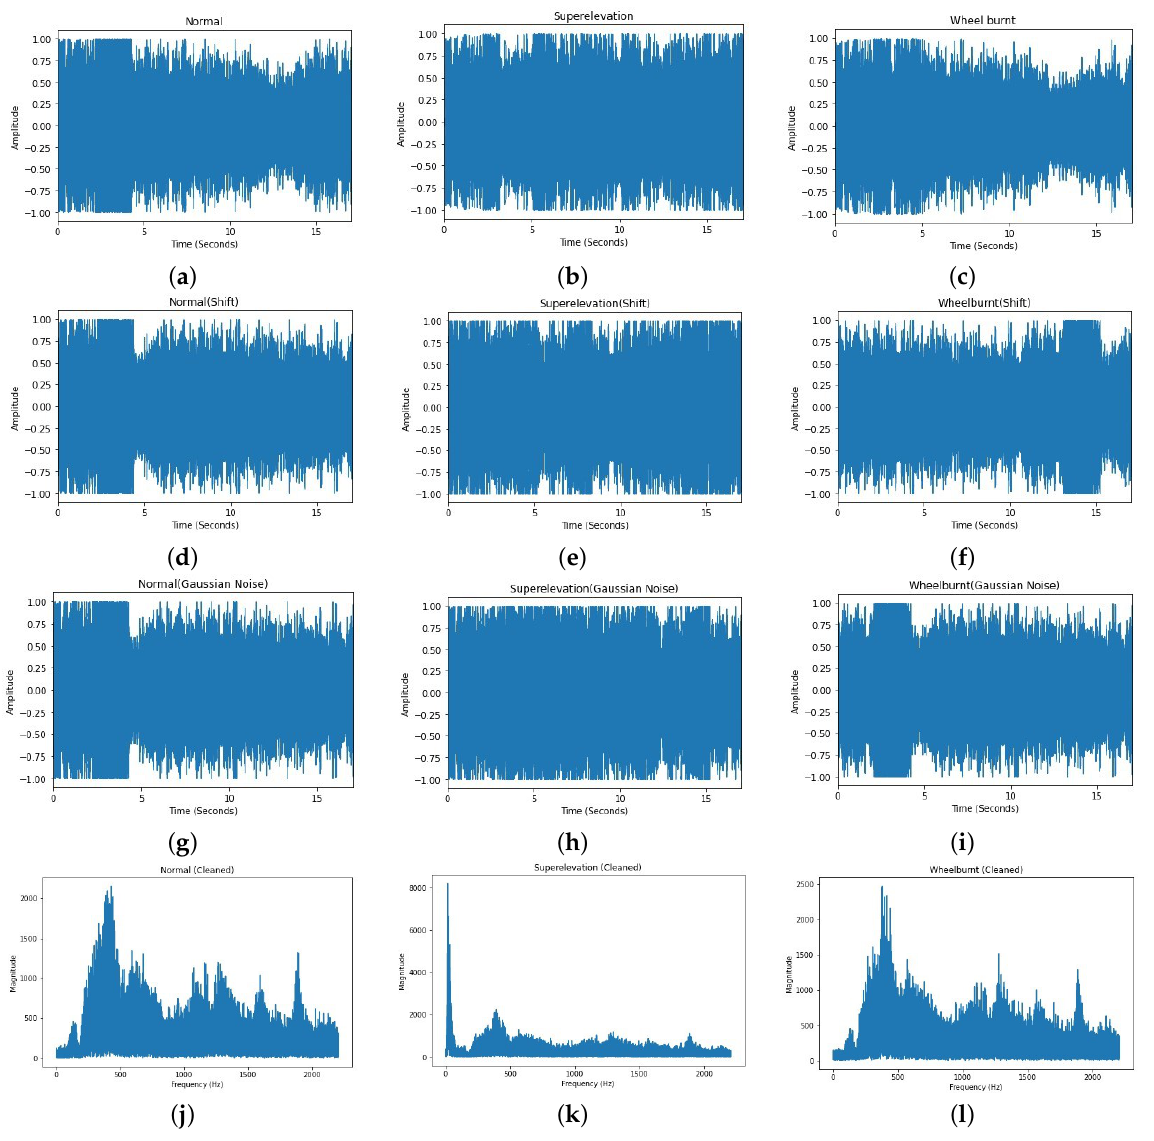
Figure 5. Time domain representation of different classes: ( a ) Normal class, ( b ) Superelevation class, and ( c ) Wheel burnt class; Time domain representation with shift augmentation: ( d ) Normal class, ( e ) Superelevation class, and ( f ) Wheel burnt class; Time domain representation with Gaussian noise augmentation: ( g ) Normal class, ( h ) Superelevation class, and ( i ) Wheel burnt class; Frequency representation of different classes, cleaned using signal envelope function and without augmentation: ( j ) Normal class, ( k ) Superelevation class, and ( l ) Wheel burnt